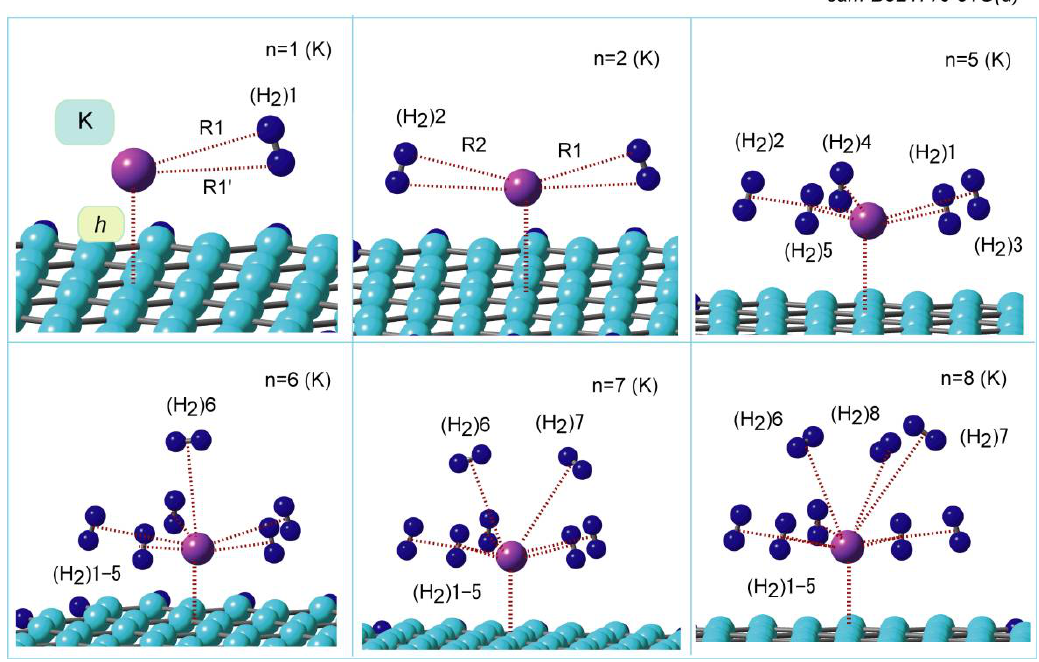
Figure 6. The optimized structures of GNF(37)–K(atom)–(H 2 ) n ( n = 1, 2, and 5–8). The calculations were performed at the CAM-B3LYP/6-311G(d,p) level.